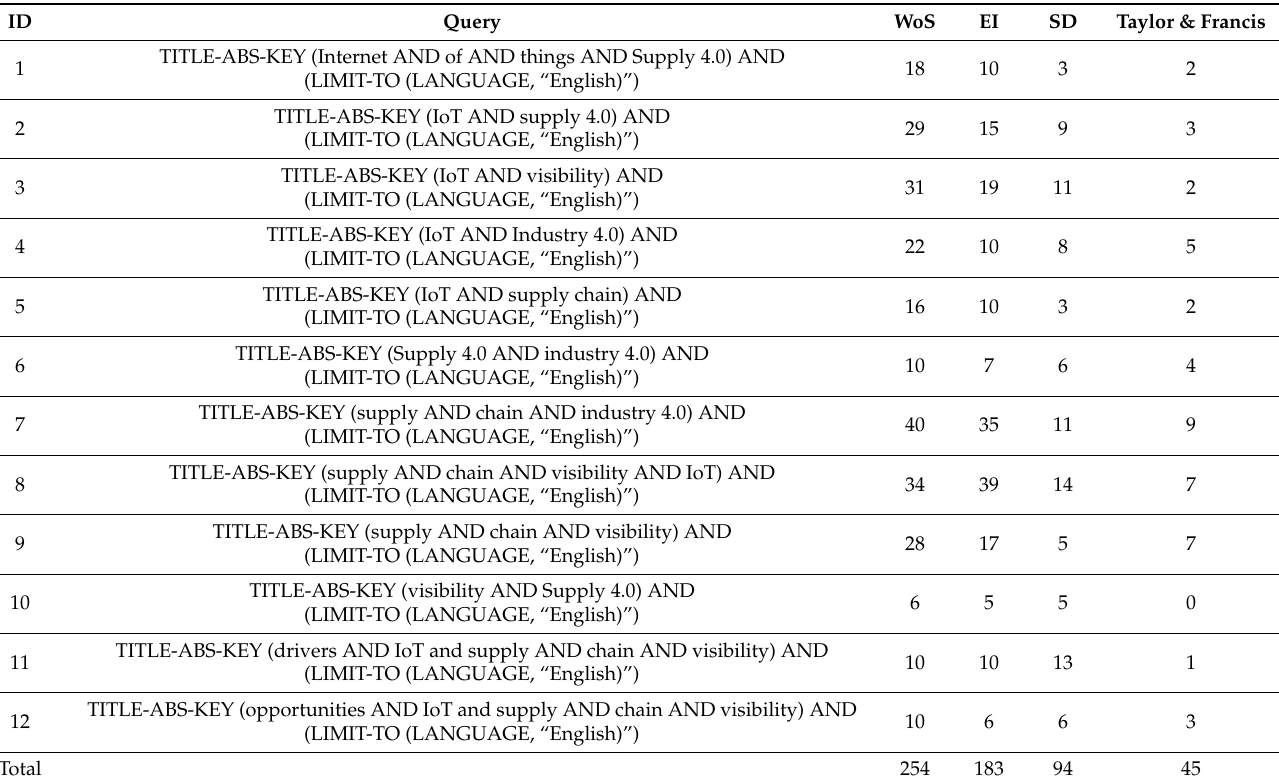
Table 1. Keywords and search strings used in